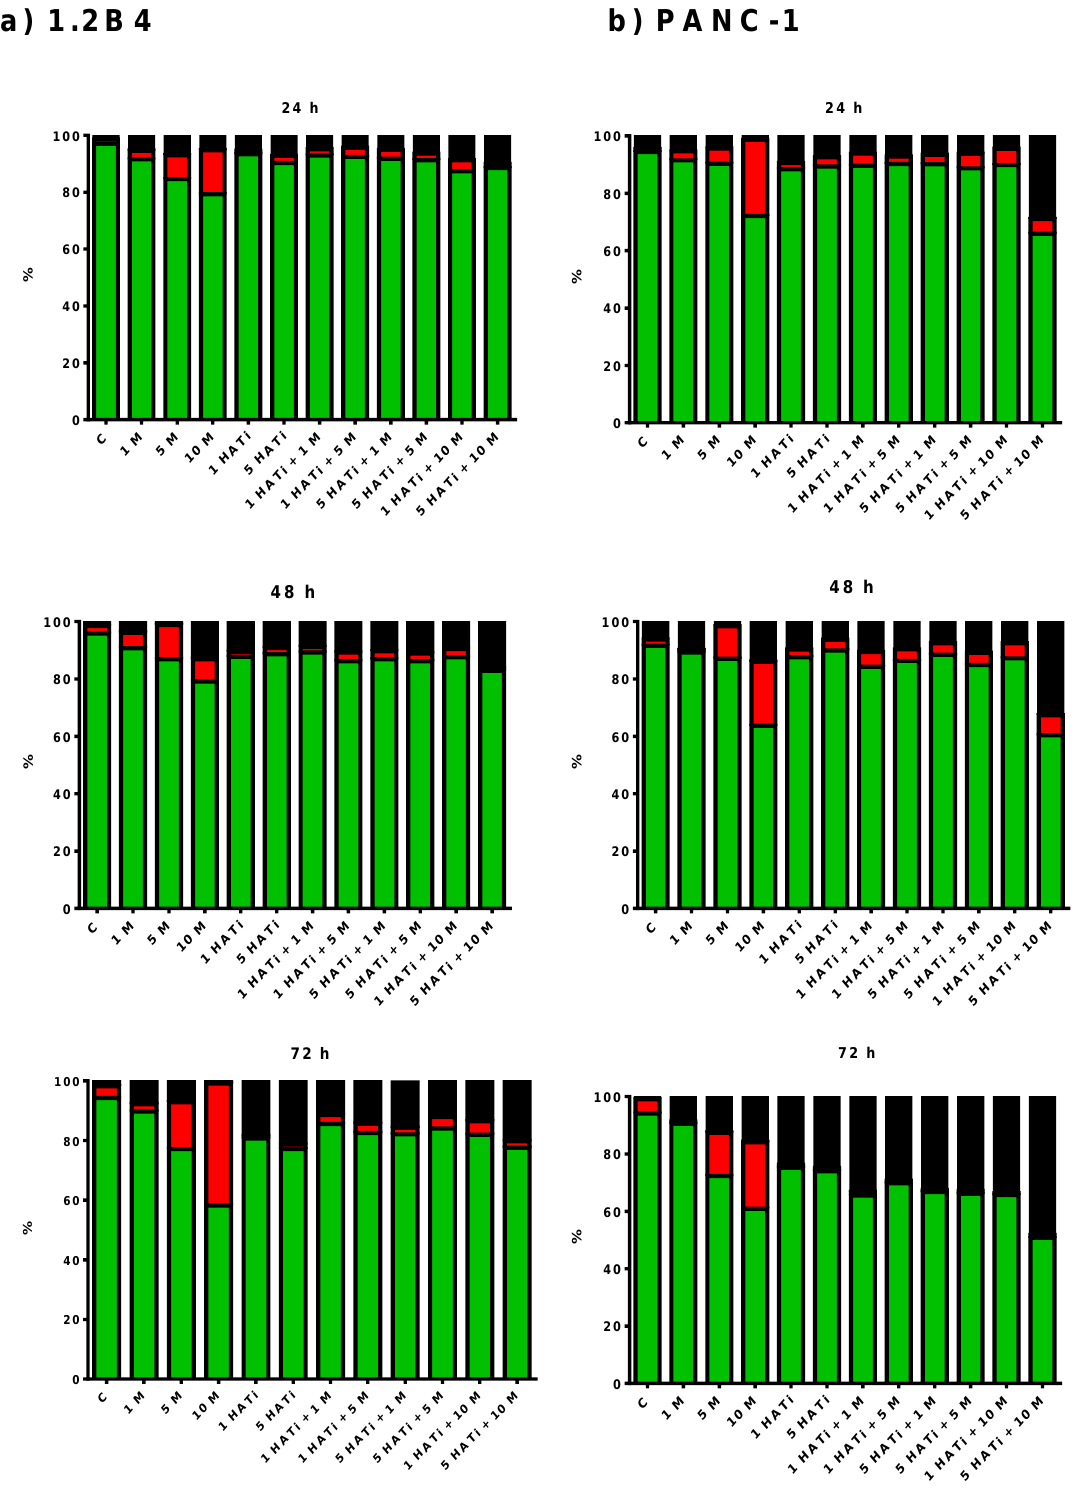
Figure 2. Proapoptotic action of metformin in PC cells. The 1.2B4 ( a ) and PANC-1 cells ( b ) were treated with metformin (1, 5, and 10 mM), HATi (1 and 5 µ M), and combination of HATi (1 and 5 µ M) with metformin (1, 5, and 10 mM) for 24, 48, and 72 h. Early apoptosis was assessed via combined staining with Ann-Cy3 and CFDA. Then, the samples were analyzed by flow cytometry within 1 h. Green bars—live cells; red bars—apoptotic cells; yellow bars—necrotic cells; and black bars—dead cells. Additional figures of the flow cytometry results have been included in Supplementary Files.